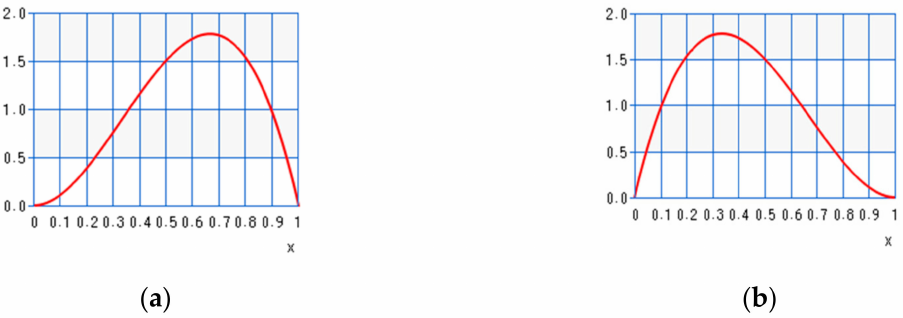
Figure 6. Beta distributions representing employee arrival/departure behaviour: ( a ) arrival ( α = 3, β = 2) and ( b ) departures ( α = 2, β =